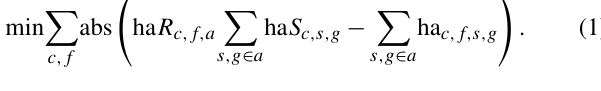
Time Crop Note erage and resolution Varies from 2001 to (sub)national administrative unit